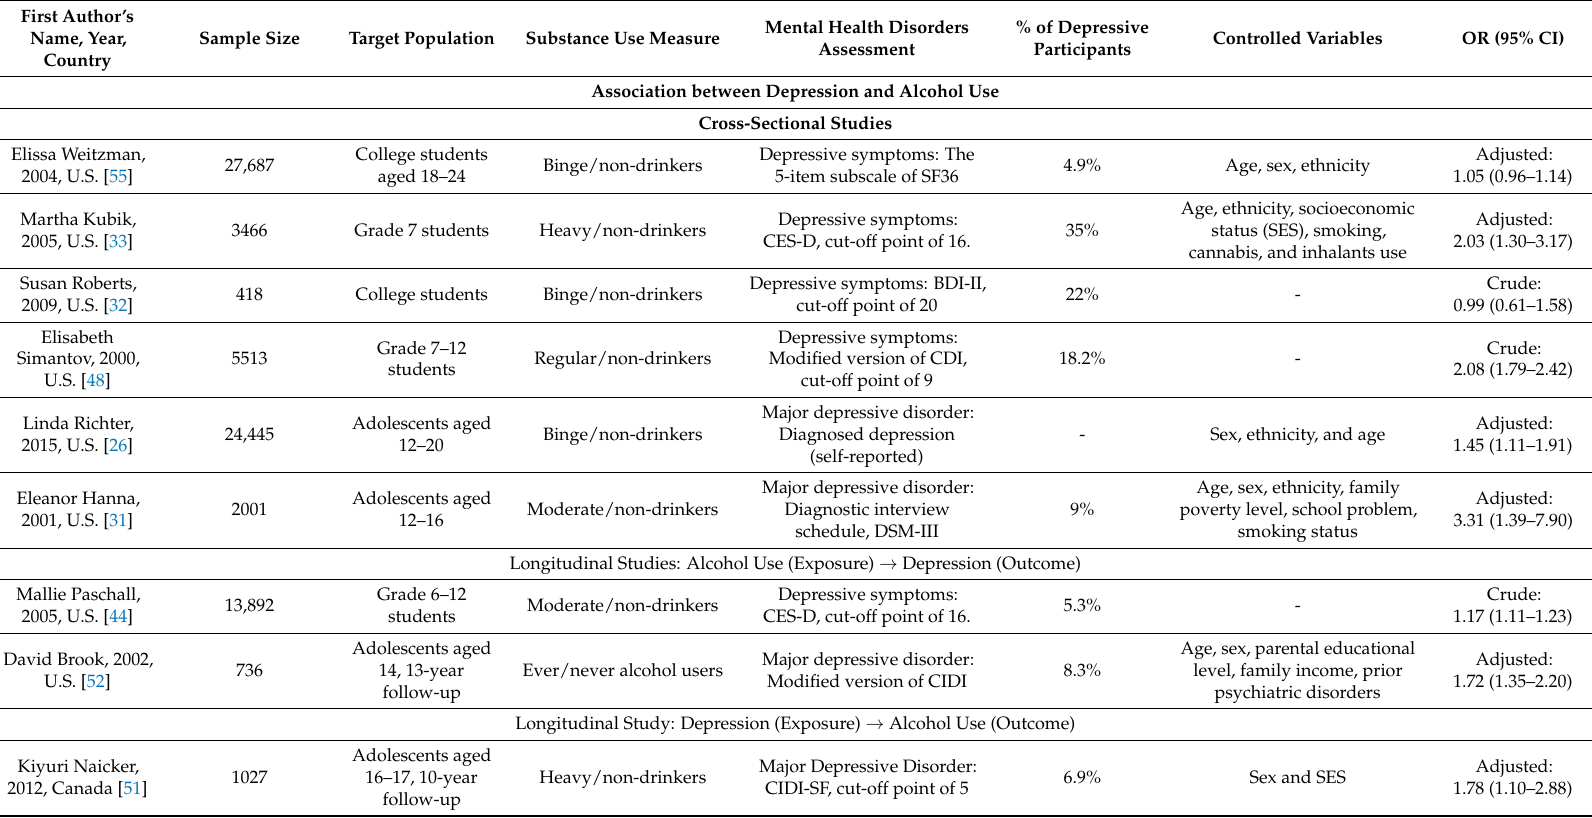
Table 1. Characteristics and associations of selected